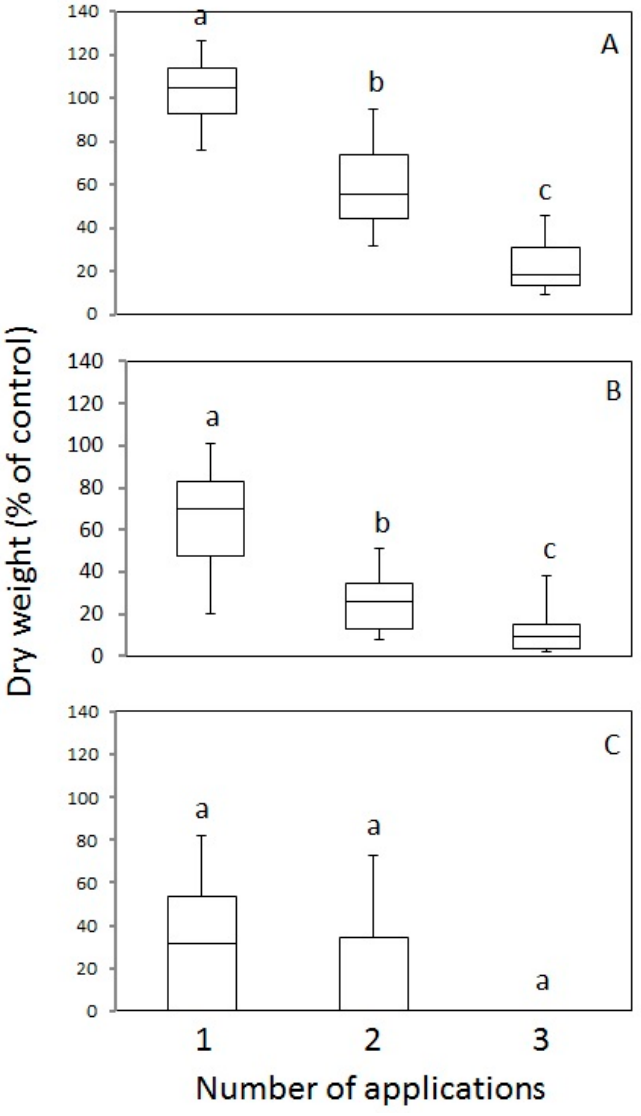
Figure 1. The impact of sequential flaming applications on the dry weight (% of control) of Sorghum halepense ( A ), Cyperus rotundus ( B ) and Ecballium elaterium ( C ). Different letters indicate significant differences, as determined by Tukey LSD test ( p ≤ 0.05). Values are means ± SD ( n = 7).